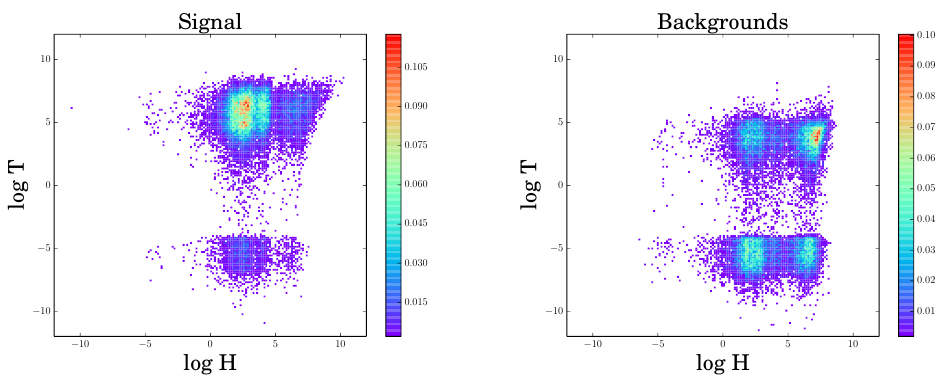
Figure 16 . log T vs˙ log H for signal (left) and all backgrounds